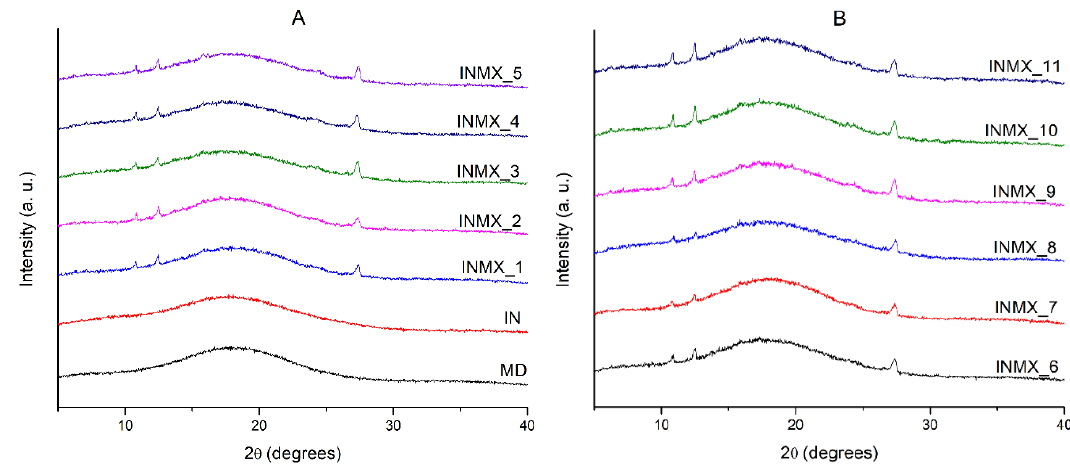
Figure 2. X-rays diffractograms of the spray-dried powders containing the active ingredients: ( A ) IN and MX blanks, and blends INMX_1-5. ( B ) Blends INMX_6-11.